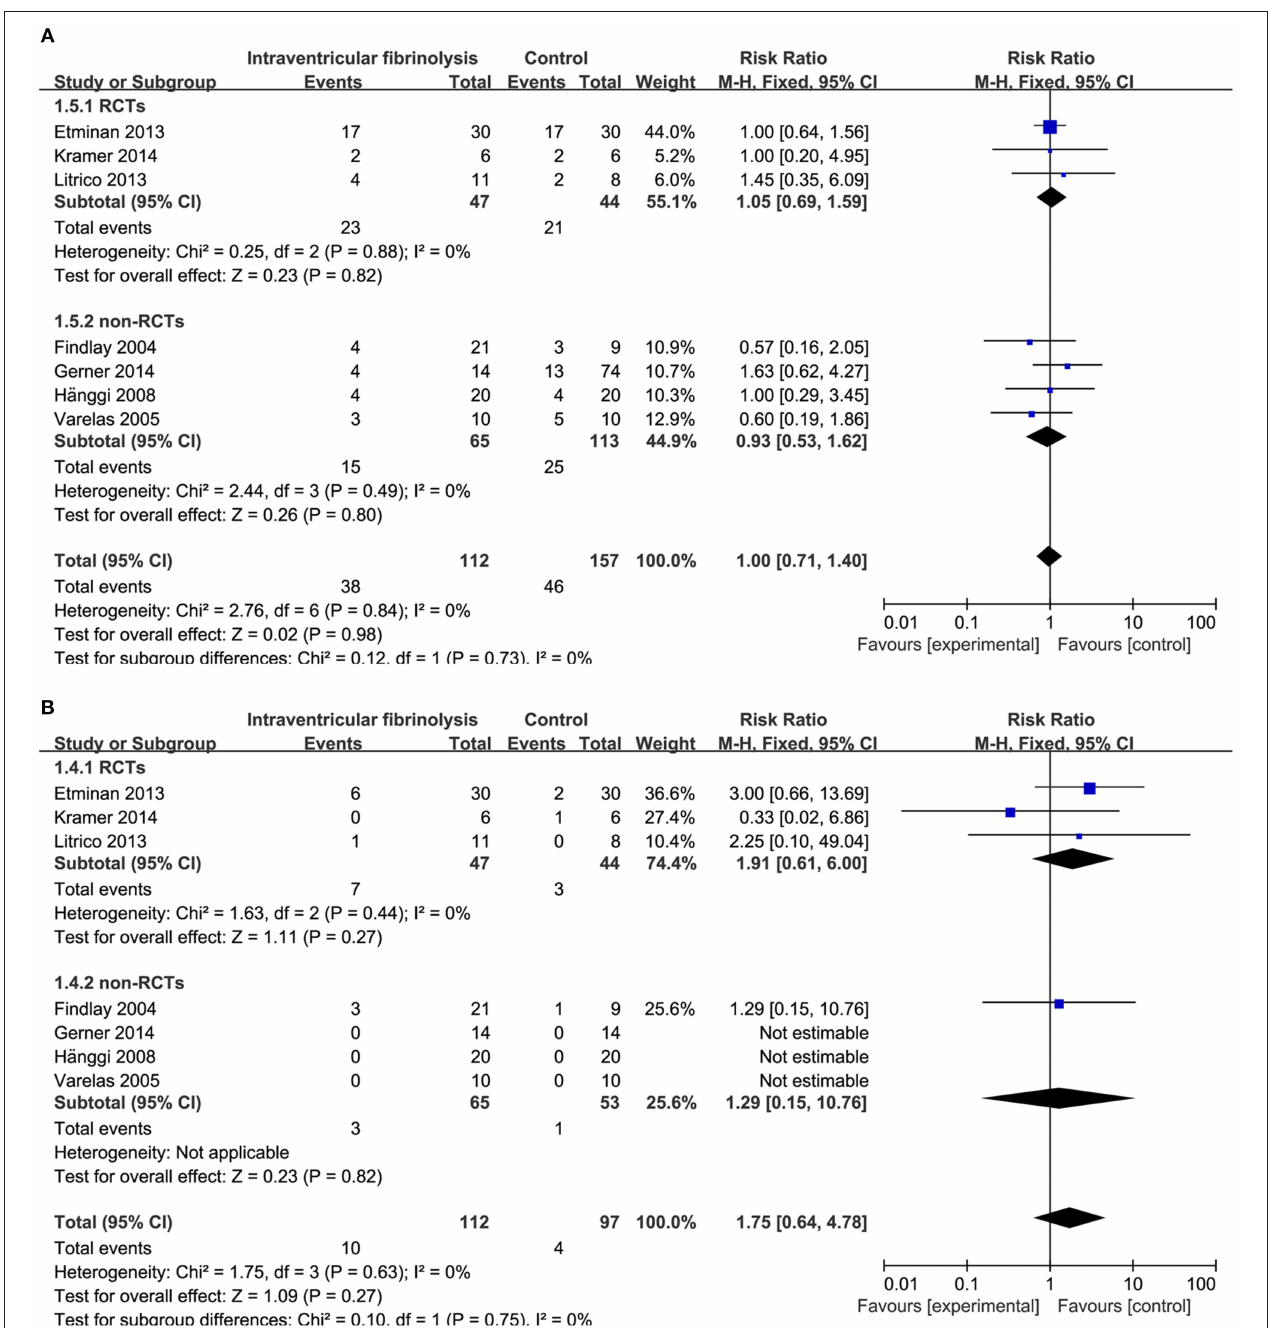
FIGURE 7 | Meta-analysis of associations between intraventricular fibrinolysis and the risk of chronic hydrocephalus (A) or the risk of hemorrhagic complications (B) in patients with aSAH. aSAH, aneurysmal subarachnoid hemorrhage; CI, confidence interval; M–H, Mantel–Haenszel method; RCTs, randomized controlled